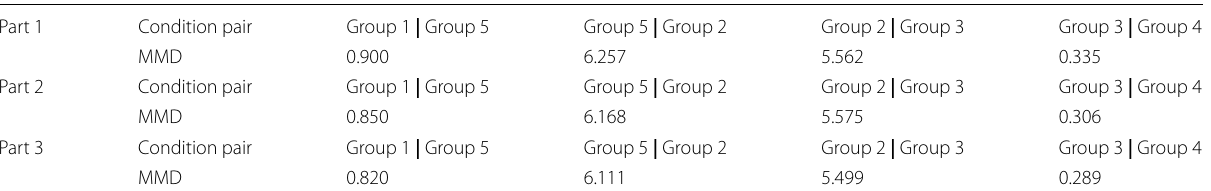
Table 2 Condition pairing of three test parts